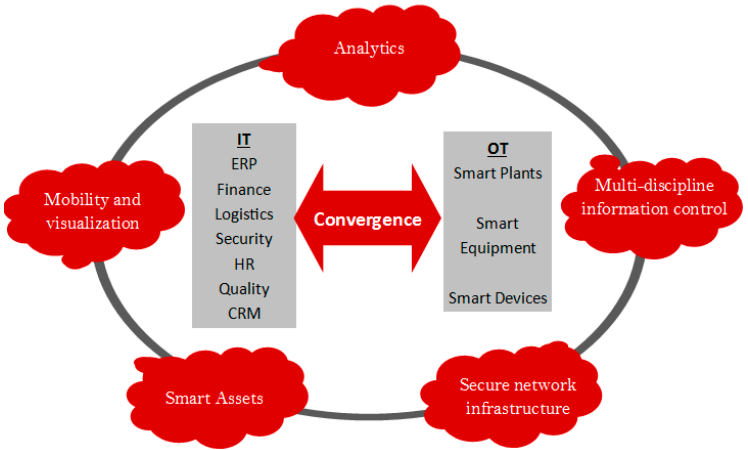
Figure 1. The Connected Enterprise strategy—enabling information technology (IT)—operational technology (OT) convergence. technology (OT)